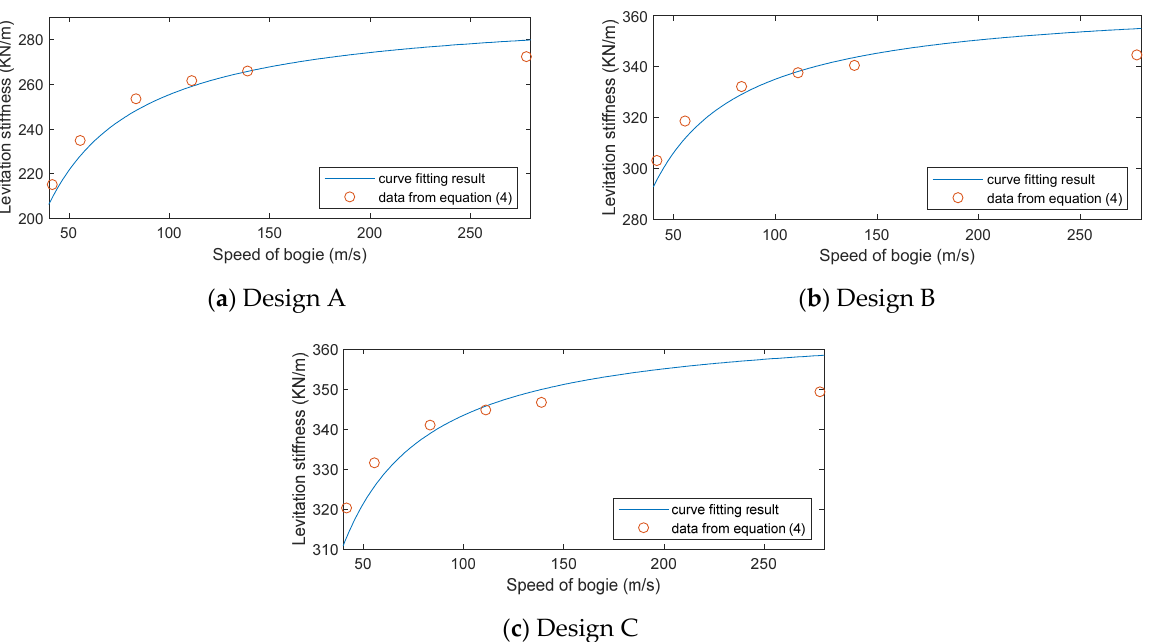
Figure 7. Levitation stiffness with respect to the speed of the traveling body.